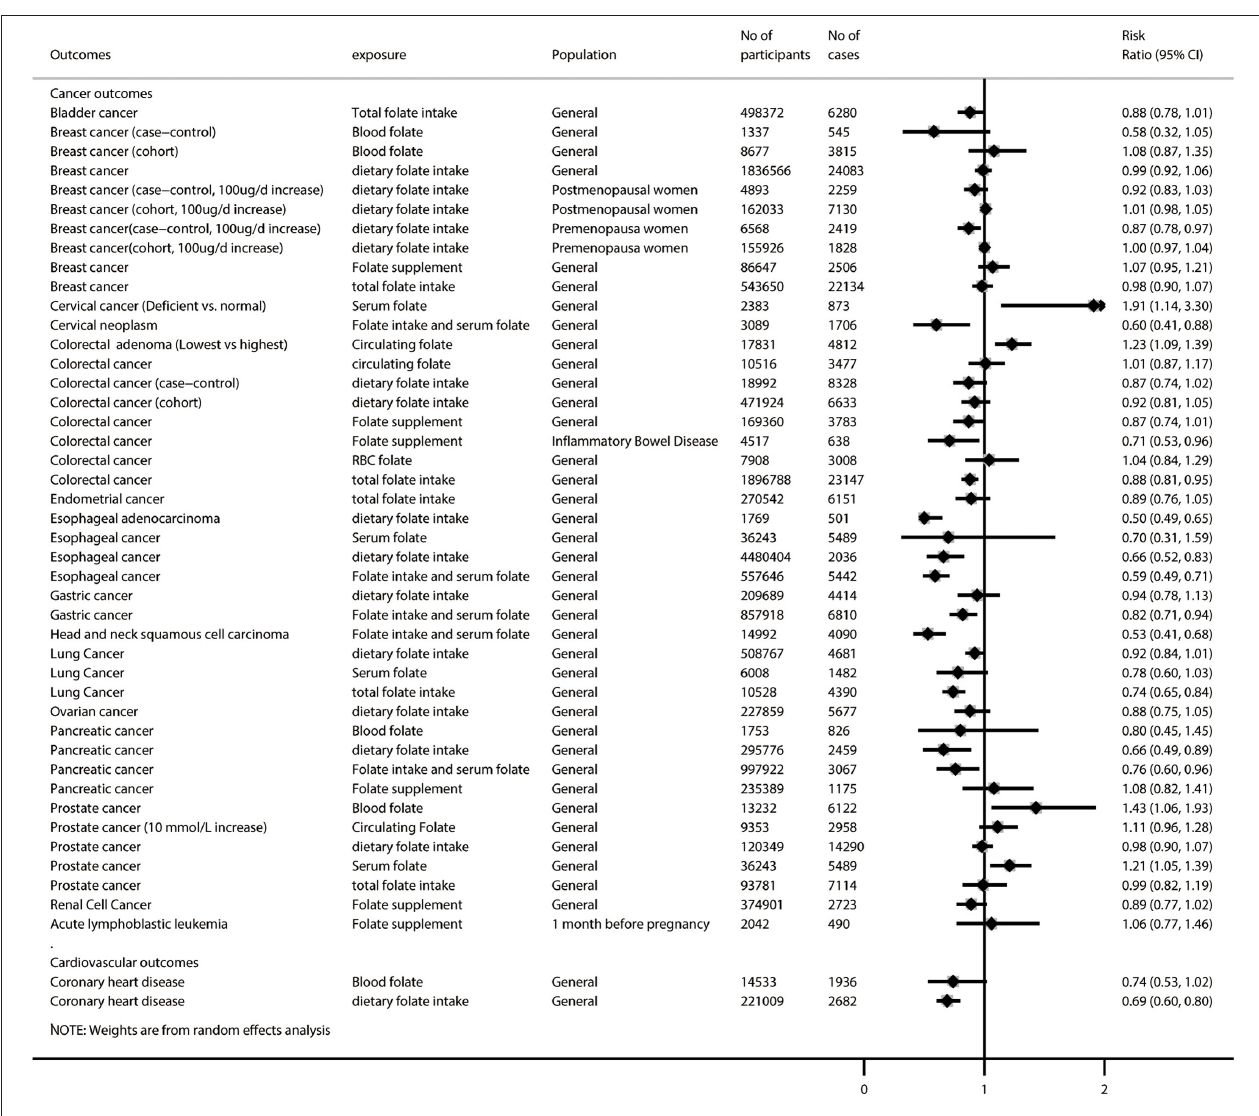
FIGURE 3 | Summary random-effects estimates of all-cause and cause-specific mortality, birth outcomes, pregnancy outcomes, neurocognitive disorders, and other outcomes reported in meta-analyses of observational studies.